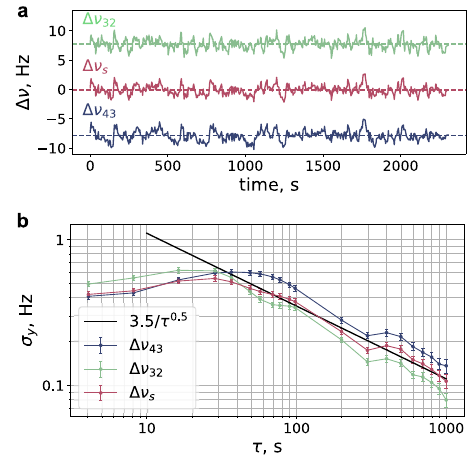
Fig. 2 Zeeman frequency shift. a Measurement of clock transition frequency shifts Δ ν 43 = ν 43 ( B m ) − ν 43 ( B r ) (blue) and Δ ν 32 = ν 32 ( B m ) − ν 32 ( B r ) (green) ¼ 218 mG for two alternately changing values of the bias magnetic fi eld B r 0 ¼ 132 mG. Common features in the Δ ν Δ ν and B m 43 and 32 data sets come 0 from clock laser frequency fl uctuations. The synthetic frequency shift Δ ν = ( Δ ν + Δ ν − 0.08(6) Hz s 43 32 )/2 is plotted in red with the mean value of (dashed line). b Allan deviation plotted for each of the data sets. The solid ffiffiffi p τ black line indicates the (cid:3) 1 = dependency. Error bars correspond to 1s.d. statistical